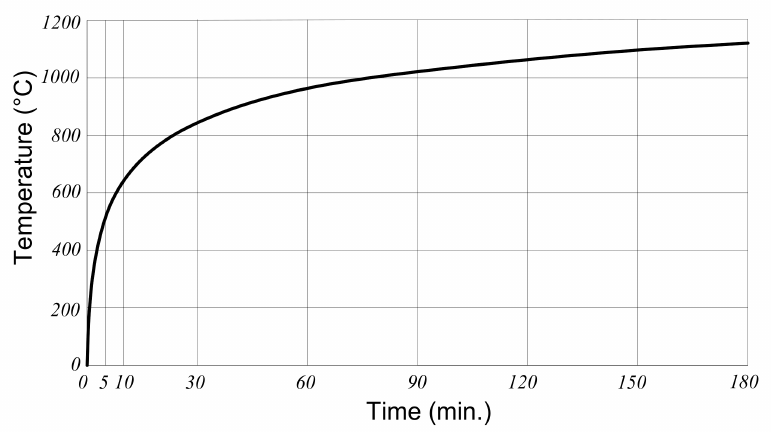
Figure 11. ETK/ISO curve adopted to describe the relationship of temperature and time in the